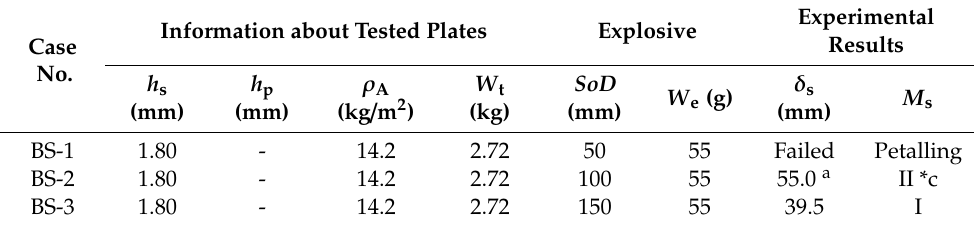
Table 4. Detailed information of the experimental results for bare steel plates [47].